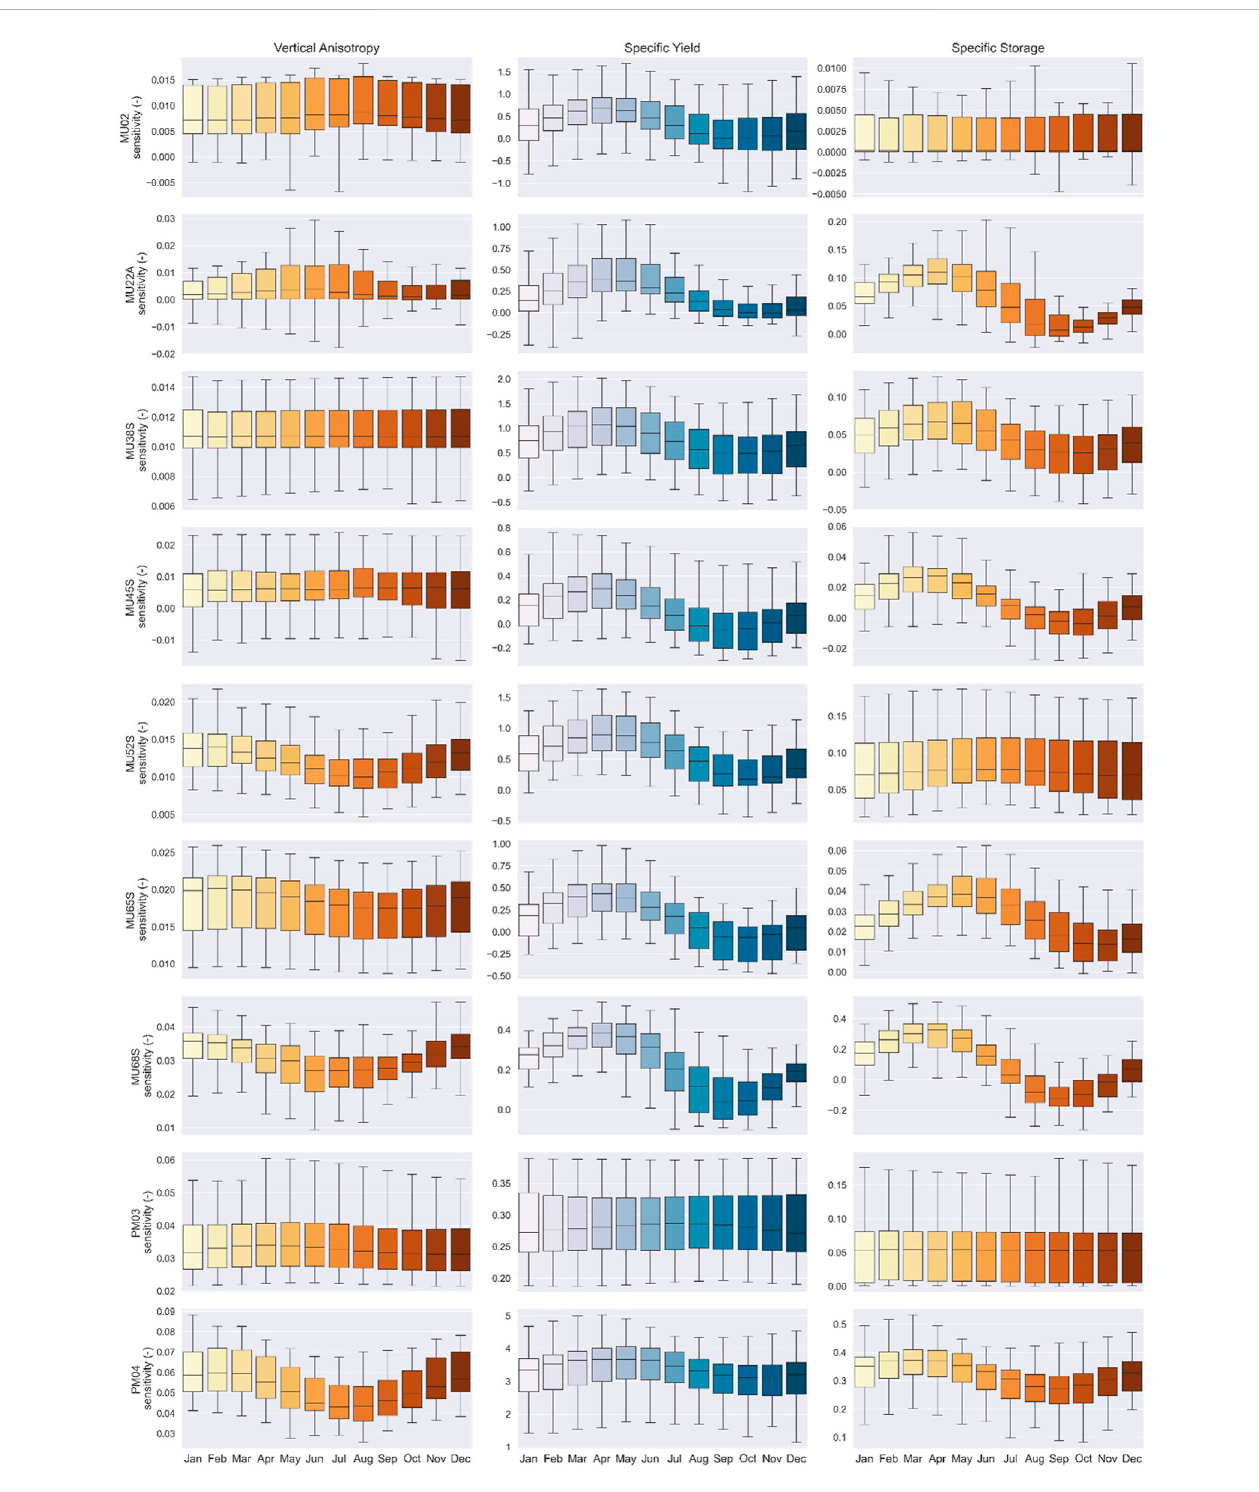
FIGURE 14 Monthly-grouped absolute sensitivity values for vertical anisotropy, speci fi c yield and speci fi c storage at selected locations.